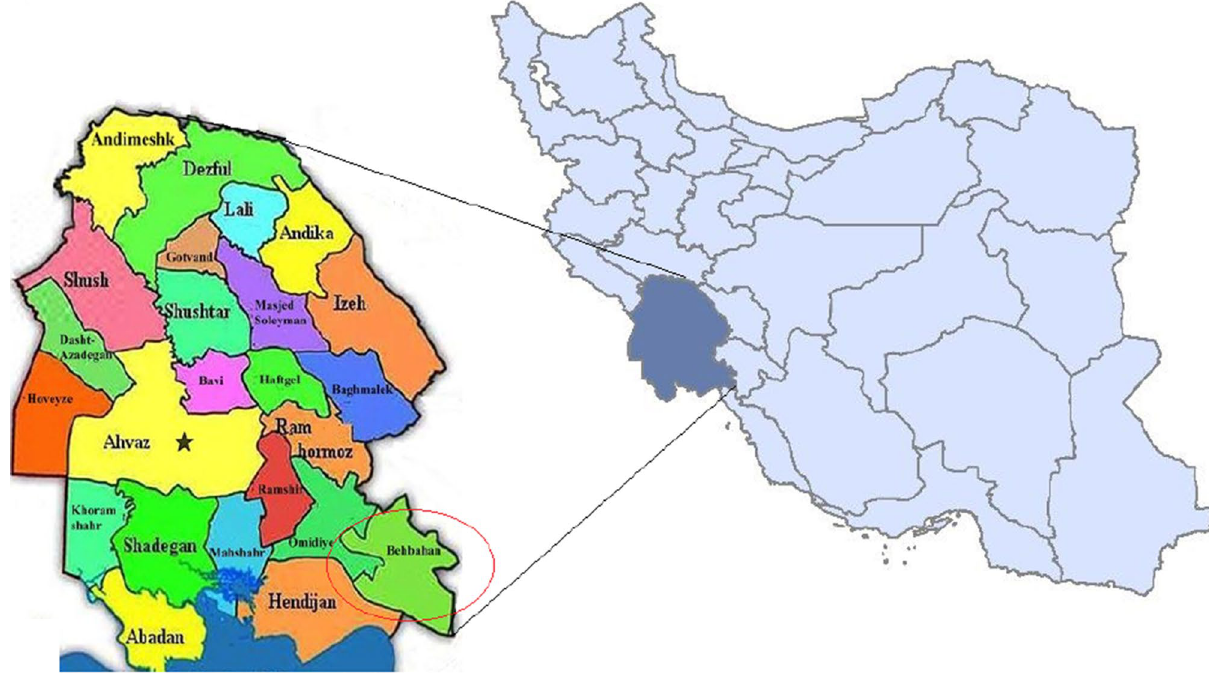
Fig. 1 Geographical location of the study area (Ghorbani et al.